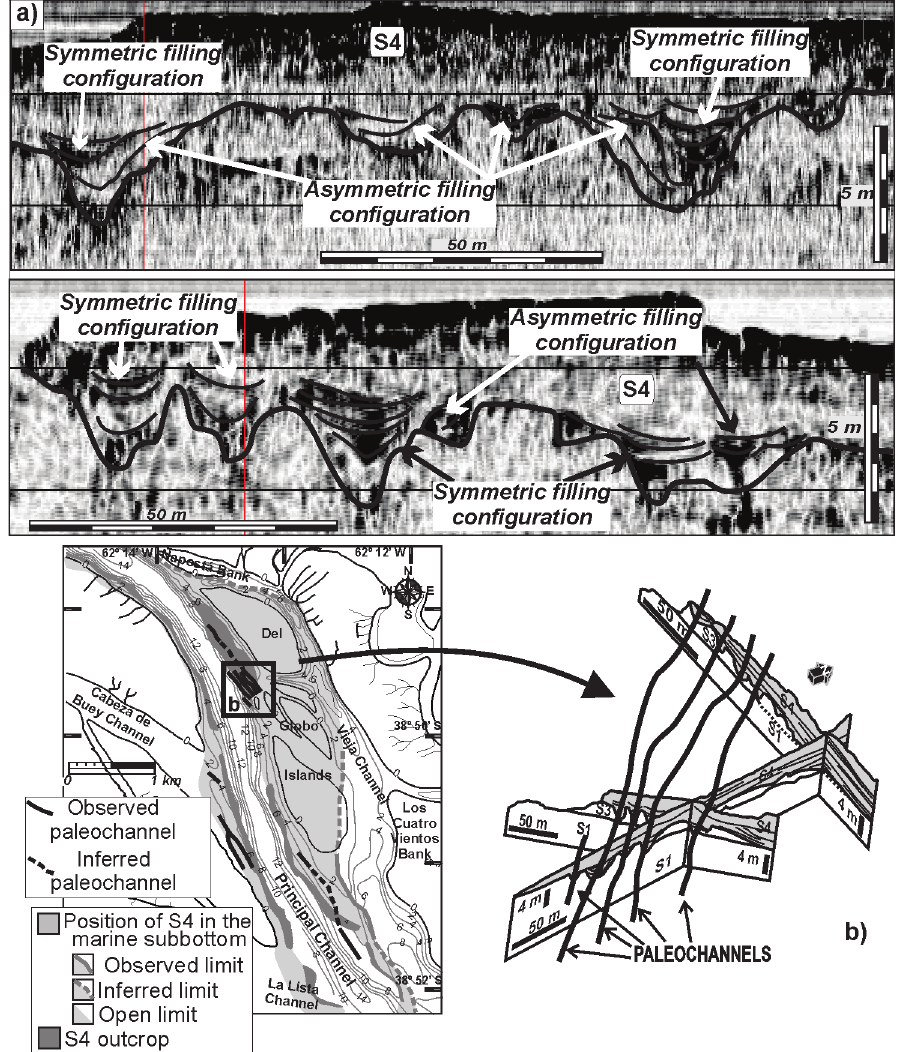
Fig. 5 - Paleochannels in the basal boundary of S4. 3.5-kHz sub-bottom records with both symmetric and asymmetric filling structures. Areal distribution of the paleochannels and 3D scheme of a sector of the eastern flank of the Principal